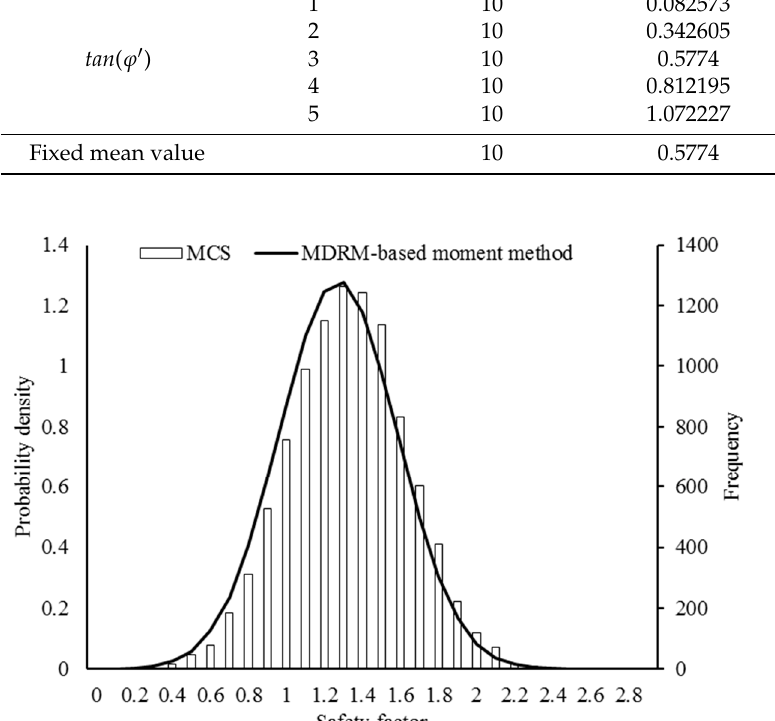
Figure 3. Probability distribution of safety factor and its comparison with MCS for frictional soil. Table 2. The statistical parameters of random variables for infinite slope without pore pressure.